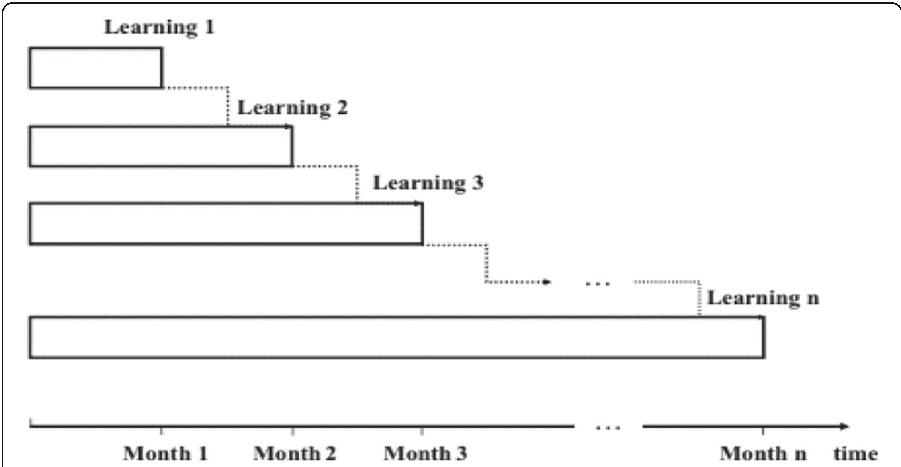
Fig. 3 Full memory time window. A dynamical modeling framework for credit risk assessment was recently proposed by Maria Rocha Sousa et al. (Sousa & Gama, 2016) that extends the prevailing models developed on the historical data static settings. This model that was inspired by the principle of films uses “ a sequence of snapshots, rather than a single photograph ” . In this dynamic modeling framework, the customer credit risk is assessed using a batch data processing model. The model deals with the defaults in two ways. This Fig is about the full memory time window which is based on all previous data and the new data is appended to the training set. As you see at the Figure, learning 2 at month2 includes learning 1